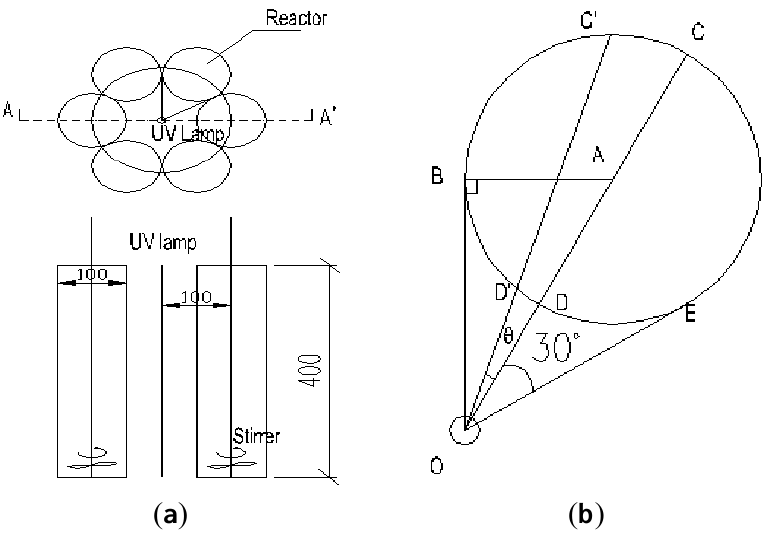
Figure 10. Demonstration of the photoreactor: ( a ) the Floorplan and A-A'cross sectional view of experimental reactor; ( b ) the outside irradiation model. C'D' = L, OD = r